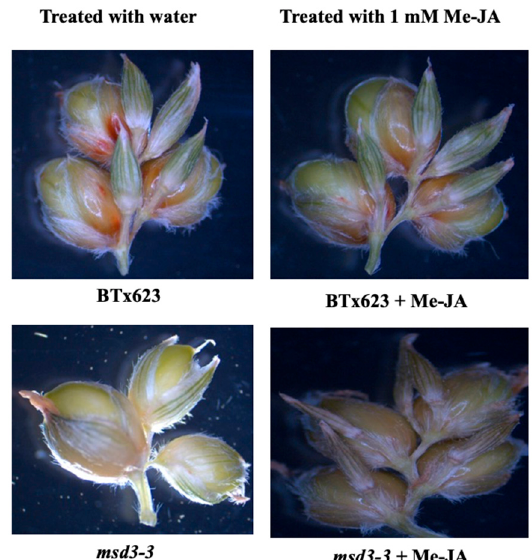
Figure 7. Reversion of the msd panicle phenotype by jasmonic acid (JA). 0.05% Tween-20 in water or 1 mM methyl-JA (MeJA) in 0.05% Tween-20 was directly applied to the central whorl of BTx623 and msd3-3 (p6) plants every other day, starting from when the plants had eight fully expanded leaves and continuing until they had 10 fully expanded leaves. Shown in the figure were a few spikelets to demonstrate the reversion of the fertile pedicellate spikelets of the msd3 mutant to sterile spikelets by the addition of MeJA. The effect of JA treatment on an entire primary inflorescence branch was shown in Figure 5S.